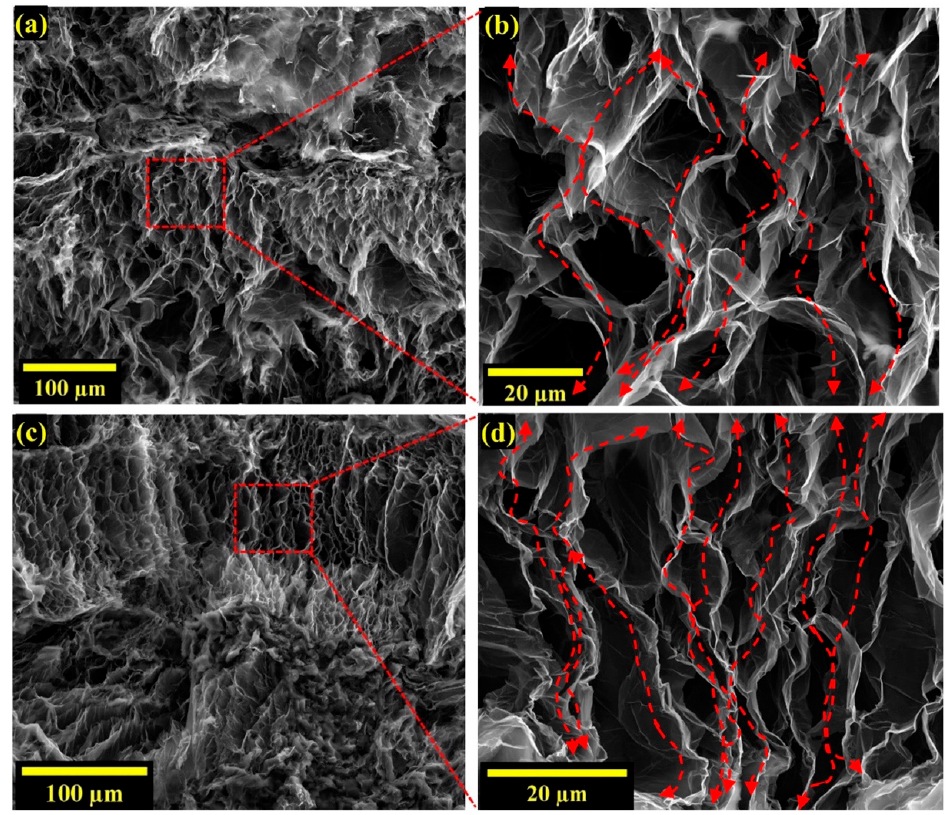
Figure 4. FE − ESEM images of EG/PEID composites with ( a , b ) 7.5 wt%, ( c , d ) 10 wt% fabricated at 20% amplitude for 40 s ultrasonication; ( a , c ) 350 × magnification, ( b , d ,) 3500 × magnification.